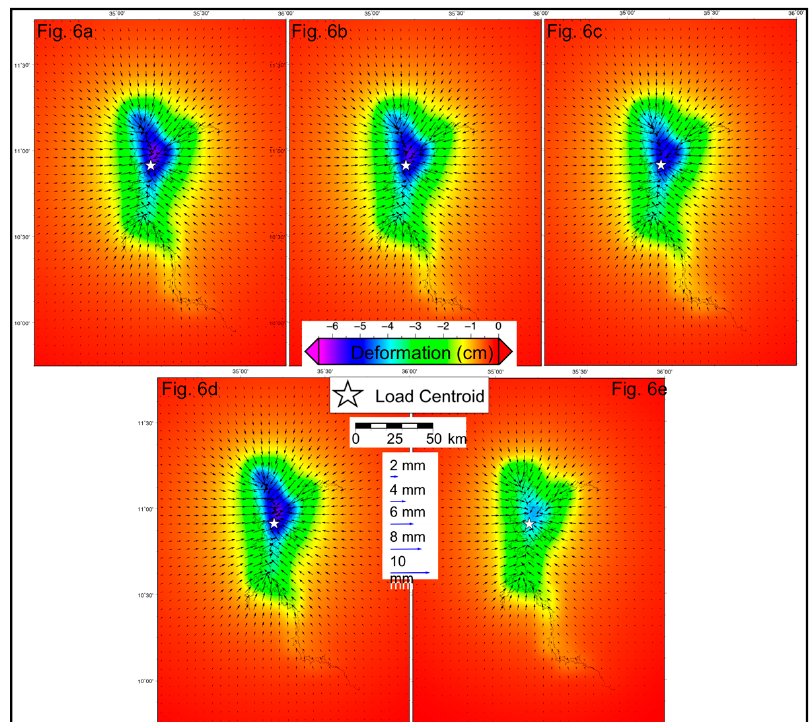
Figure 6. Total vertical and horizontal displacements from the maximum annual amplitude for each of the five 39-year operational scenarios. The modeled vertical displacement is plotted on the colored grid while the horizontal displacement motion vectors are plotted on top. The maximum water level weighted hydrologic load centroids are plotted as stars, and the maximum areal extent of the reservoir for each of these scenarios is drawn as a black polygon. ( a – e ) correspond to the maximum displacement out of the full 39-year dataset for each of the five di ff erent seasonal operational scenarios (L1–L5). We plot the daily maximum vertical and horizontal accumulated flexural responses from the full 39-year dataset for each of the five scenarios in Figure 7. We start the water level for each of these runs such that the maximum water level over the full 39-year dataset is never greater than the maximum GERD water level of 640 m. We note that the seasonal maximum and minimum vertical and horizontal displacements for all five scenarios over all 39 years of hydrologic data are 6.58 and 1.32 cm (vertical) and 9.58 and 1.91 mm (horizontal), respectively. This further highlights the stark di ff erences in the annual stresses applied on the crust from the varying hydrologic loading and unloading operational scenarios of the